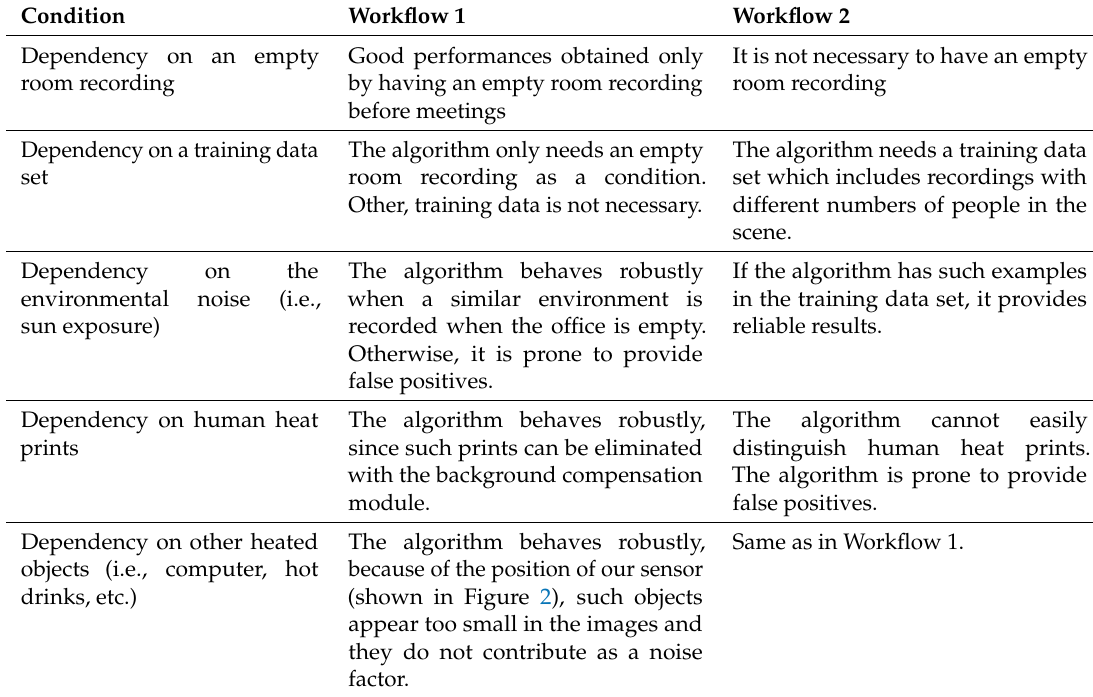
Table 4. Comparison of the different occupancy prediction workflows (one computer vision-based, two machine